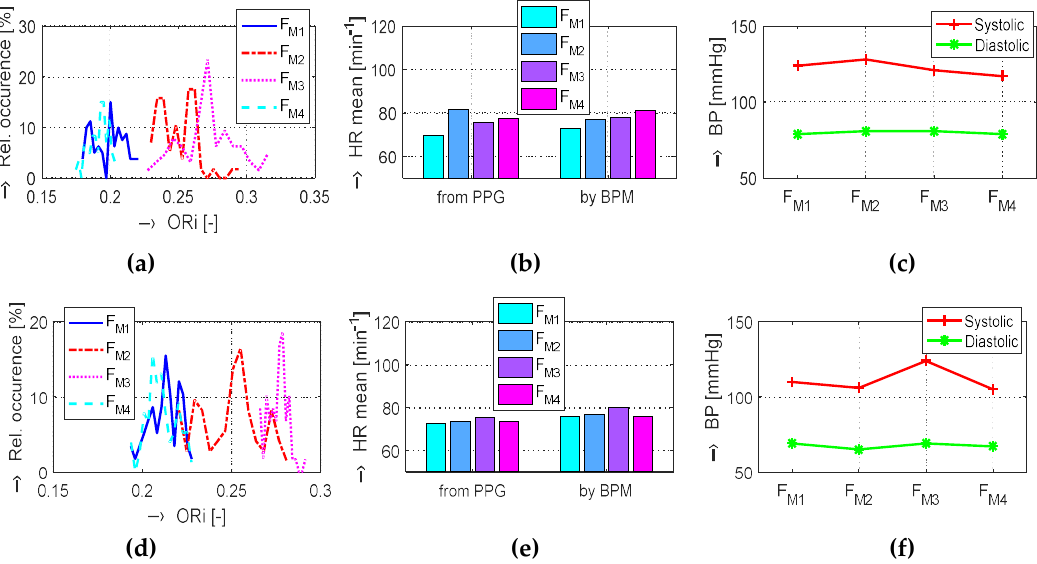
Figure 9. Visualization of changes of cardiovascular parameters determined in the initialization/relaxation (F M1 , F M4 ), and after the stimulation phase while hearing the MRI noise through headphones (F M2 , F M3 ), for a male (upper graphs) and a female (bottom graphs) tested person: ( a , d ) comparison of histograms of ORi values, ( b , e ) bar-graphs of HR determined from the PPG signal and measured by the BPM device, ( c , f ) comparison of systolic and diastolic blood pressure